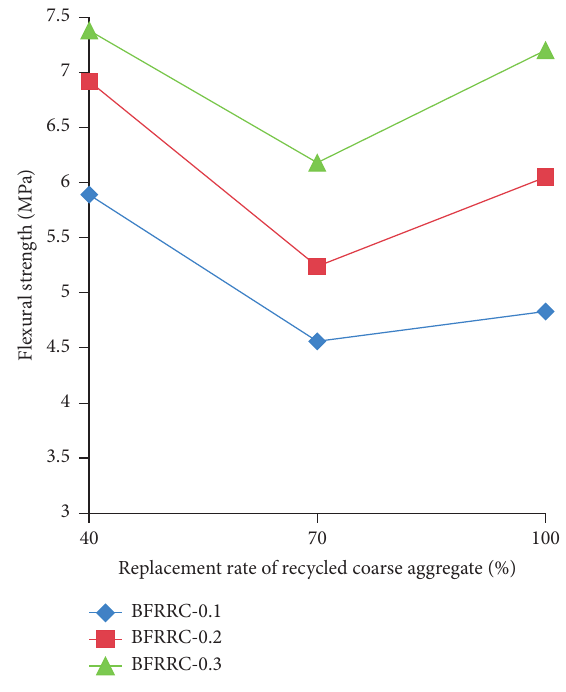
Figure 7: Flexural strength curve of